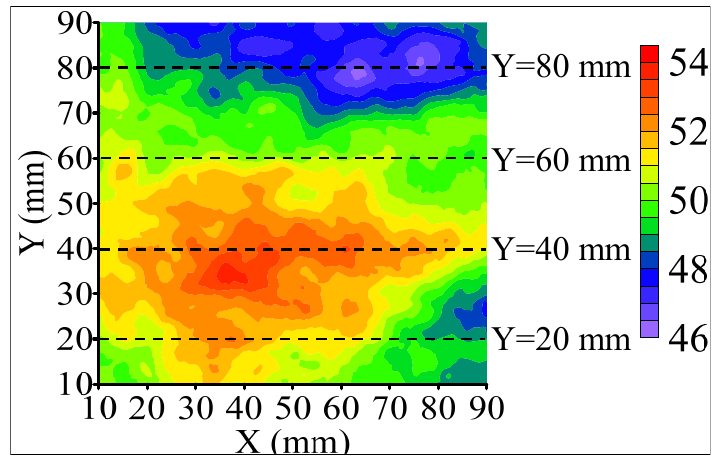
Figure 6. Schematic diagram of 2D contour line location. Because the correlation coefficient between the root means square z 2 of the first de ‐ rivative of the height of the shape curve and the roughness coefficient JRC was the largest, R 2 = 0.993 [46]. Thus, z 2 was used to estimate JRC, and the calculation is as follows: